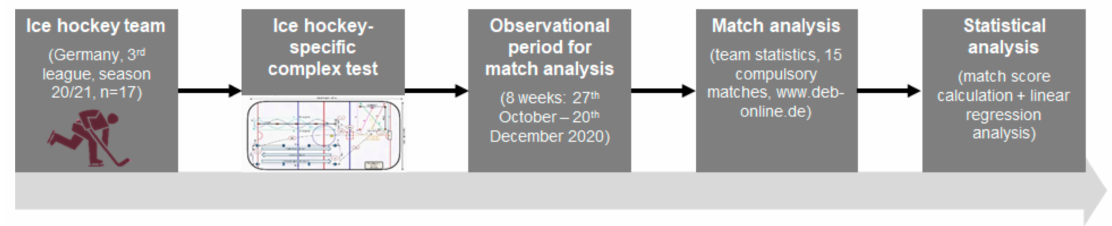
Figure 1. Study protocol—from the sample recruitment to the data analysis.